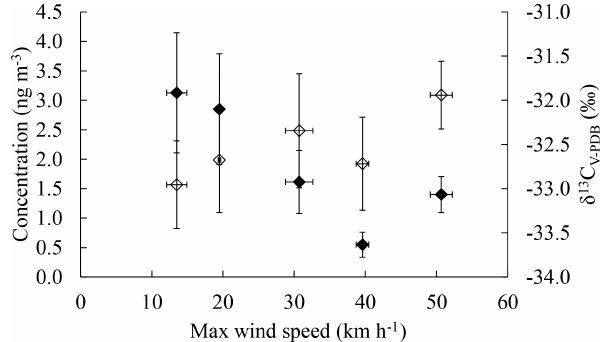
Figure 8. Plot of concentrations (black diamonds, left axis) and carbon isotope ratios (open diamonds, right axis) of 2-methyl- 4-nitrophenol as a function of the maximum wind speed during sampling (Environment Canada, Historical Weather Data, Toronto North York site). Points were sorted in order of increasing wind speed, and each point is an average of 10 filter samples; the samples collected while there was precipitation were excluded. Error bars are the errors of the mean.